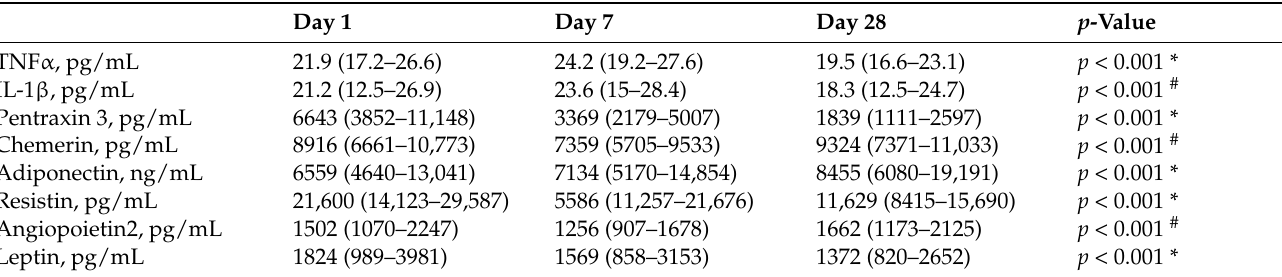
Table 3. The changes of serum biomarkers in patients with